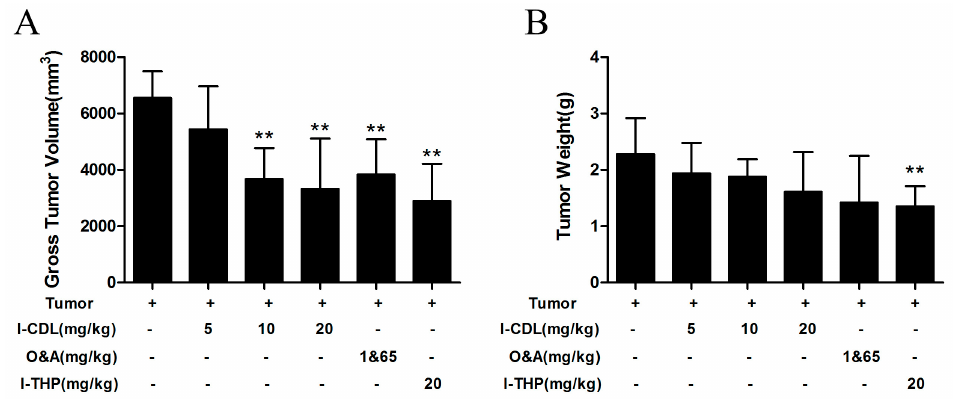
Figure 8. l -CDL alleviated the tumor compression in the sciatic nerve. ( A ) Effects of l -CDL on tumor volume; ( B ) Effects of l -CDL on tumor weight. ** p < 0.01 vs. the tumor group (mean ± S.D., n = 7).